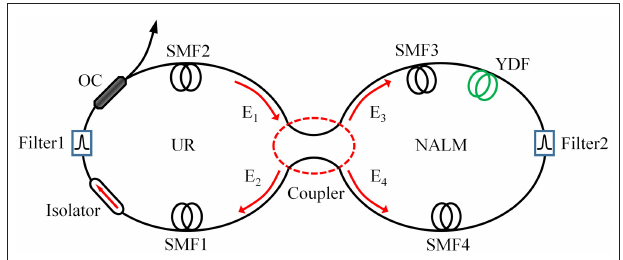
FIGURE 1 | Schematic of an ANDi Yb-doped figure-of-eight fiber laser.